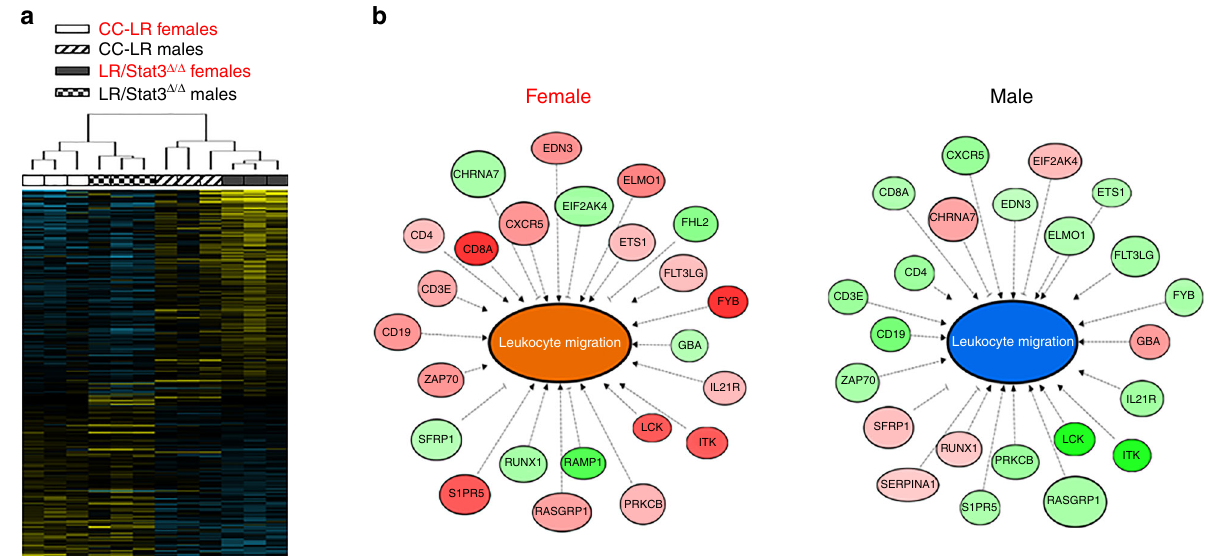
Fig. 2 Sex-differential immune expression programs in lungs of epithelial-speci fi c K-ras mutant Stat3 de fi cient mice. a Whole-transcriptome sequencing of whole lungs from 14-week-old CC-LR and LR/ Stat3 Δ / Δ male and female mice ( n = 3 within each genotype and sex group; n = 12 total) was performed using the Ion Torrent Proton platform and as described in the Methods section. Differentially expressed transcripts ( n = 339) were identi fi ed using a mixed-effects model as described in the Methods section and analyzed by clustering. Rows represent gene features and columns denote samples (yellow, upregulated compared to median sampled; blue, downregulated expression). b Differentially expressed transcripts were functionally and topologically analyzed by pathways and gene set analysis using IPA as described in the Methods section. The gene – gene interaction networks depict signi fi cantly predicted inhibition of leukocyte migration and associated gene sets in Stat3 -deleted males with the opposite pattern in the female counterparts (orange, activated molecular function; blue, inhibited molecular function; red, upregulated expression; green, downregulated